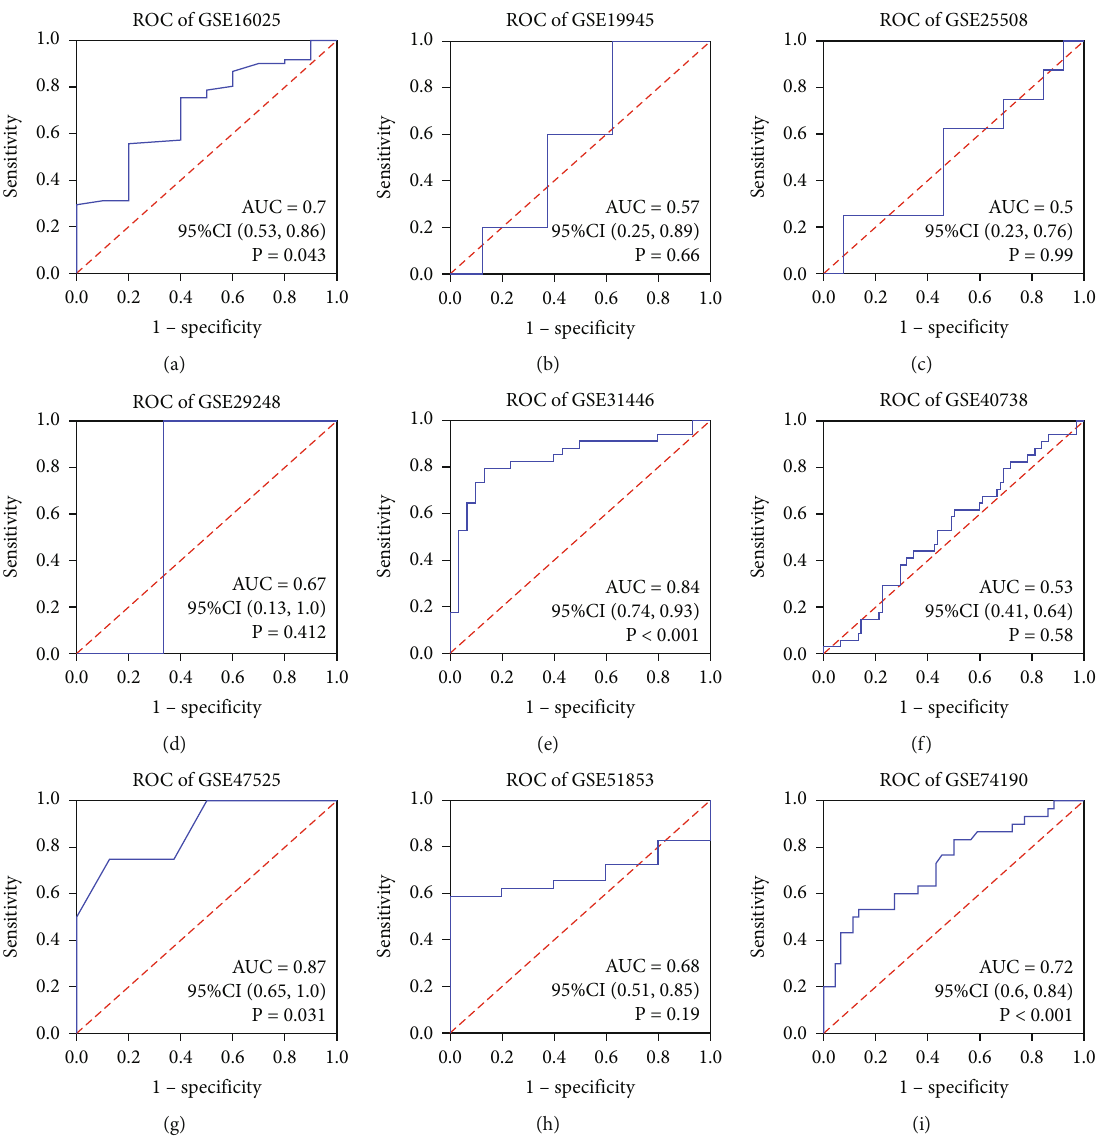
Figure 4: ROC curves based on miRNA microarray datasets. A panel of ROC curves shows the diagnostic ability of miRNA-33a-5p for LUSC in each of the included miRNA microarray datasets. AUC: 0.5 – 0.7 (low), 0.7 – 0.9 (moderate), and 0.9 – 1.0 (high). P < 0 : 05 indicates a statistically signi fi cant di ff erence. ROC: receiver operating characteristic; AUC: area under the curve; CI: con fi dence